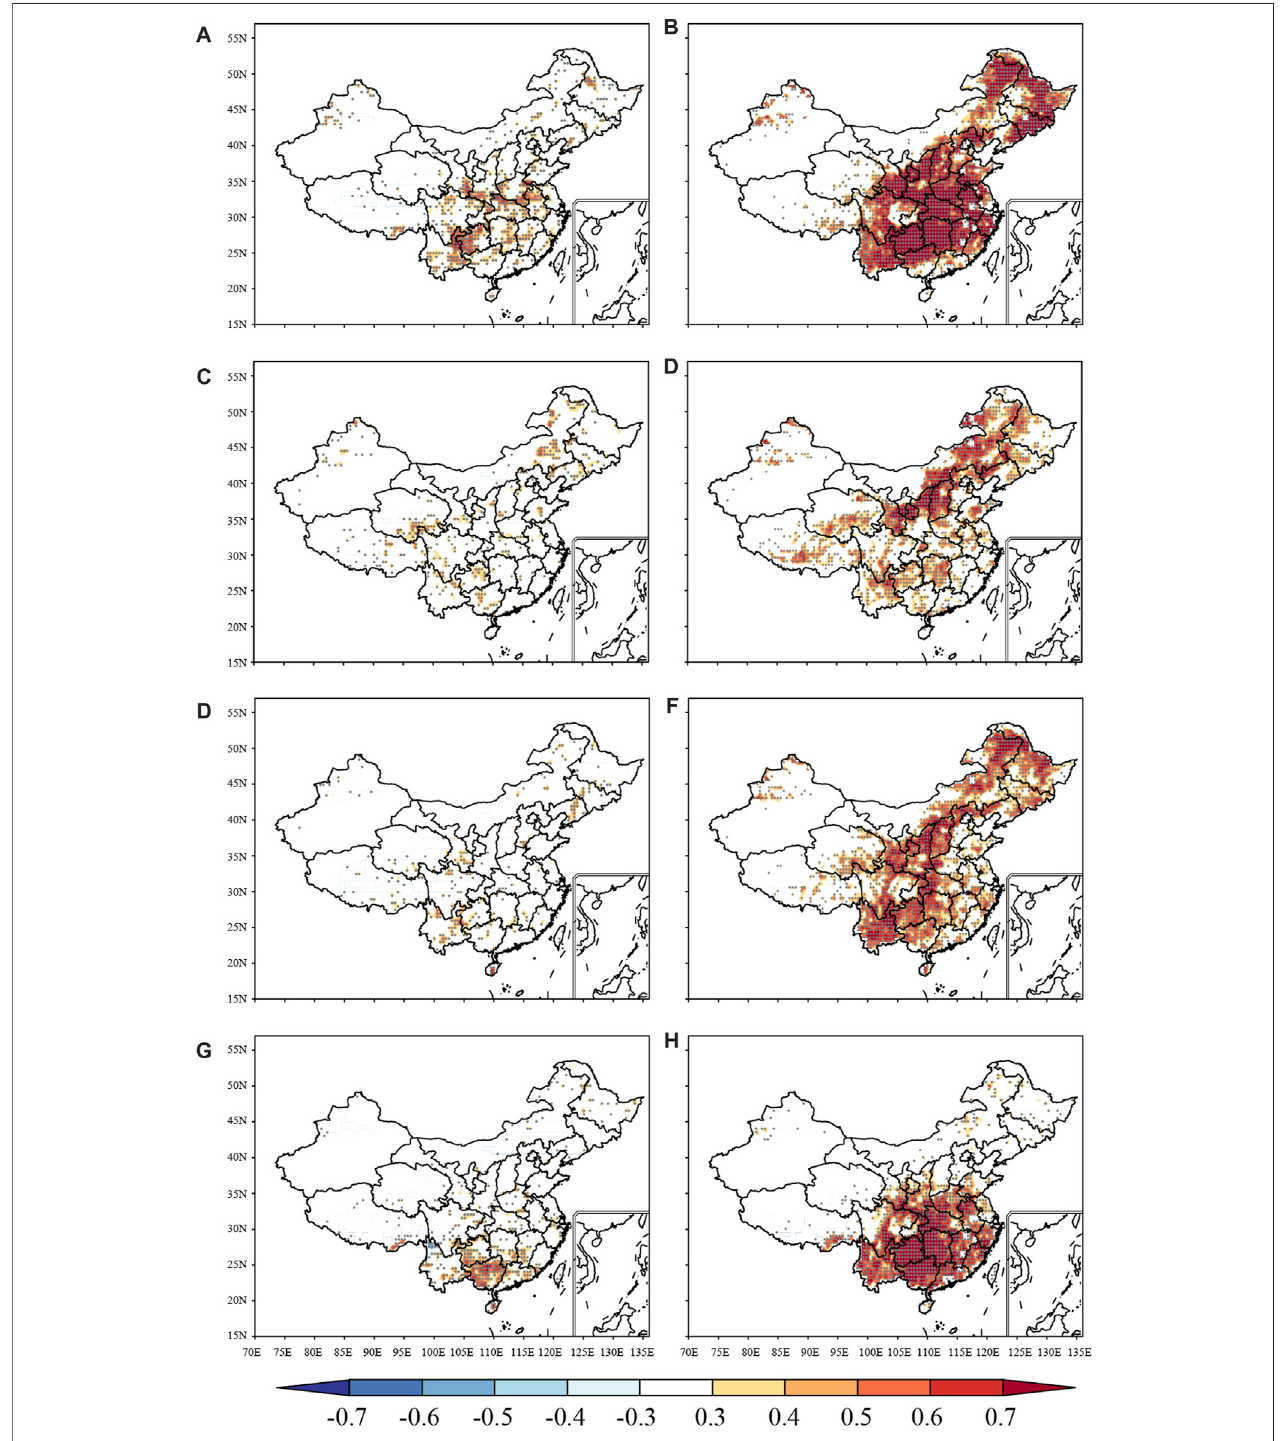
FIGURE 3 | The pixel correlation coef fi cients of Δ LAI with Δ ET and Δ (T/ET), respectively. The fi rst column is Δ ET and the second is Δ (T/ET). Spring (A,B) summer (C,D) autumn (E,F) and winter (G,H) . The dots indicate the correlation coef fi cient passing the signi fi cance test at the 5% level. correlations between Δ ET and vegetation changes are not as evapotranspiration to vegetation is different (Niu et al., 2019) strong as those between Δ (T/ET) and vegetation changes, and has a more pronounced impact on transpiration than showing that the sensitivity of transpiration and evaporation. The changes of T/ET in spring and winter are